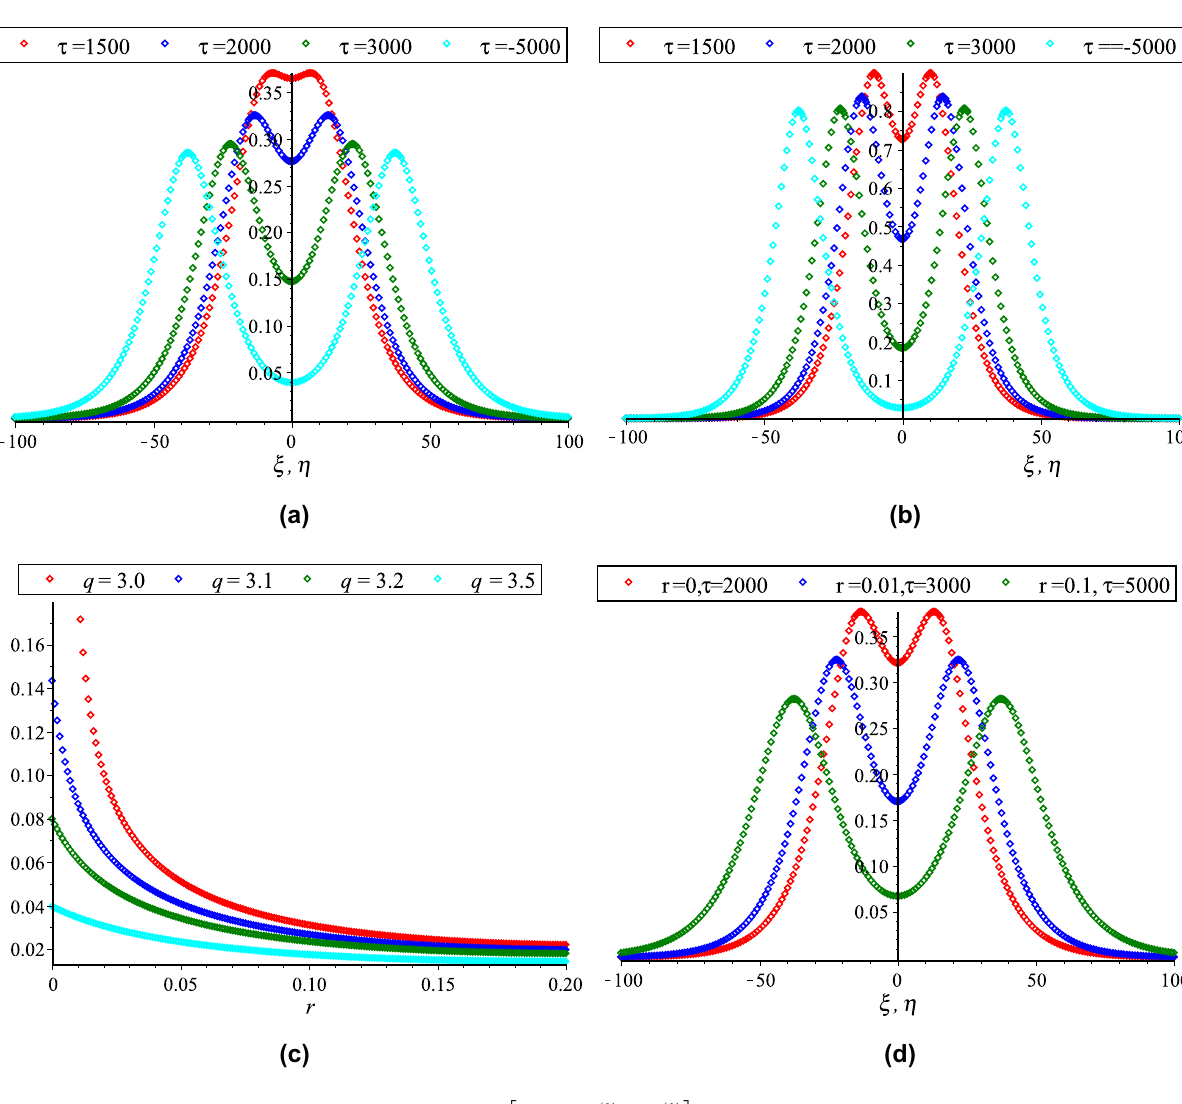
Figure 6. Collisional PA